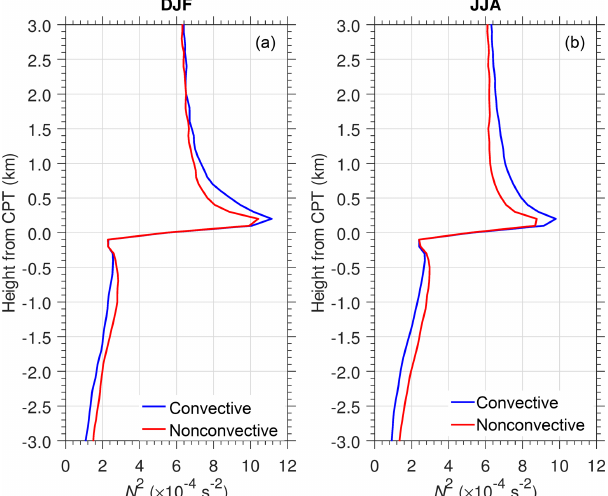
to 10 . 4 × 10 − 4 s − 2 and tended to increase d H from 0.3 to 0.5 km.